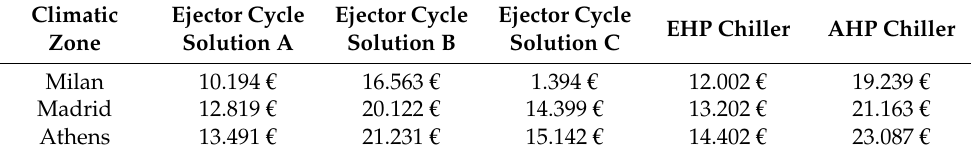
Table 6. Investment